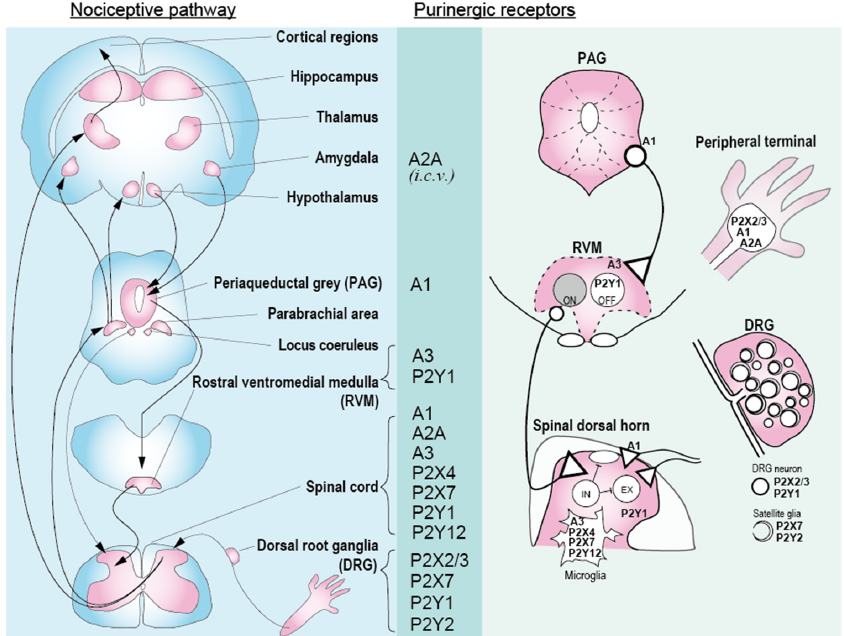
Figure 1. Major nociceptive pathway from peripheral to central nervous system (rodent’s structure).